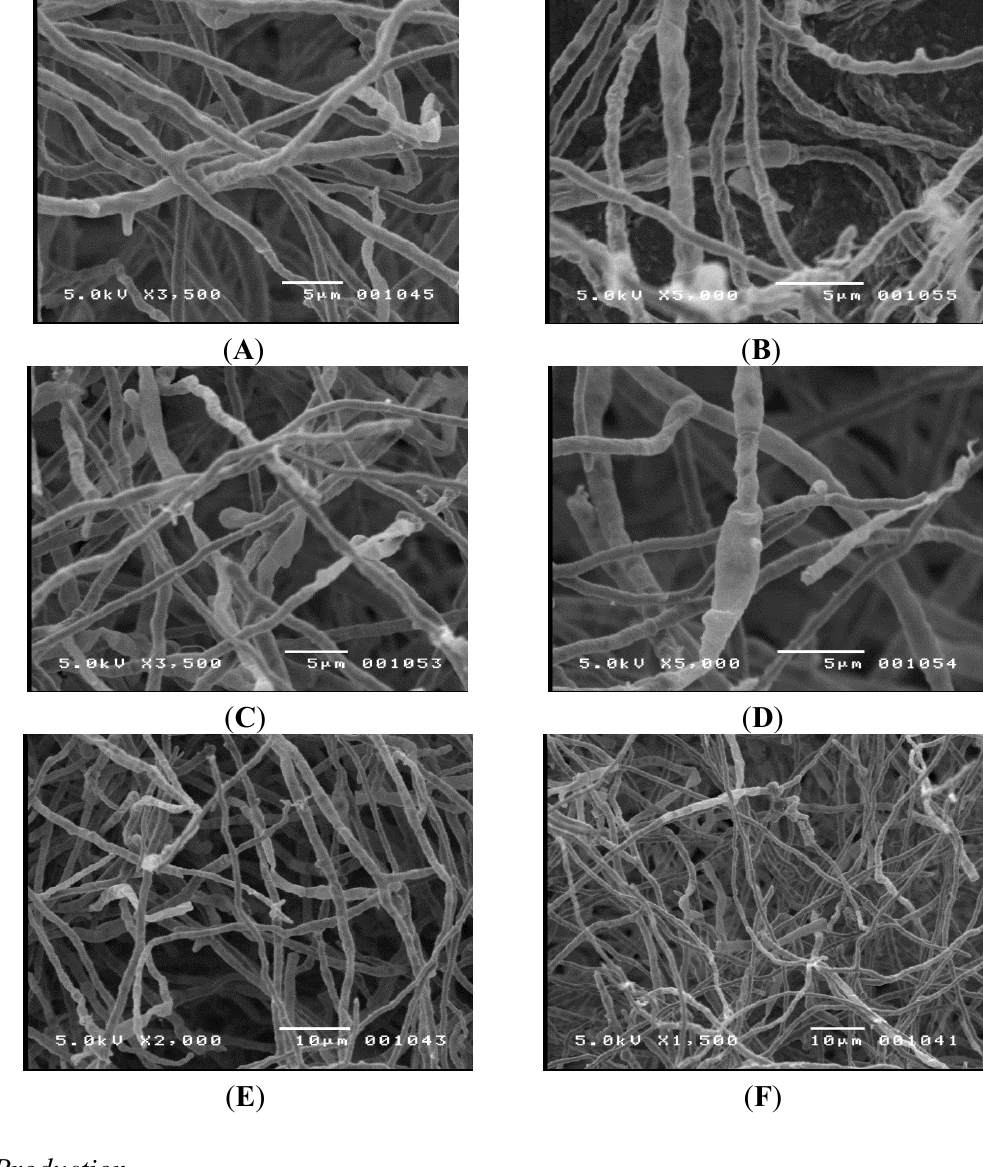
Figure 2. Scanning electron microscopy images of TM-417 performed on a JEOL JSM-5400 scanning electron microscope (JEOL; Tokyo, Japan). No identifying structures were noticed. ( A ) 3500× magnification; ( B ) 5000× magnification; ( C ) 3500× magnification; ( D ) 5000× magnification; ( E ) 2000× magnification; ( F ) 1500× magnification. A swollen cell can be seen in ( D